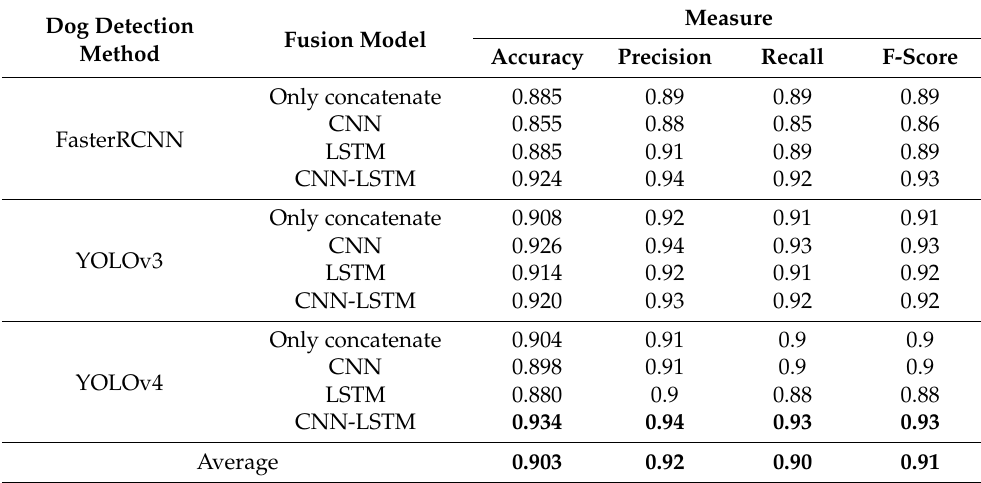
Table 7. Results of behavior recognition performance evaluation by fusion models based on multi- modal